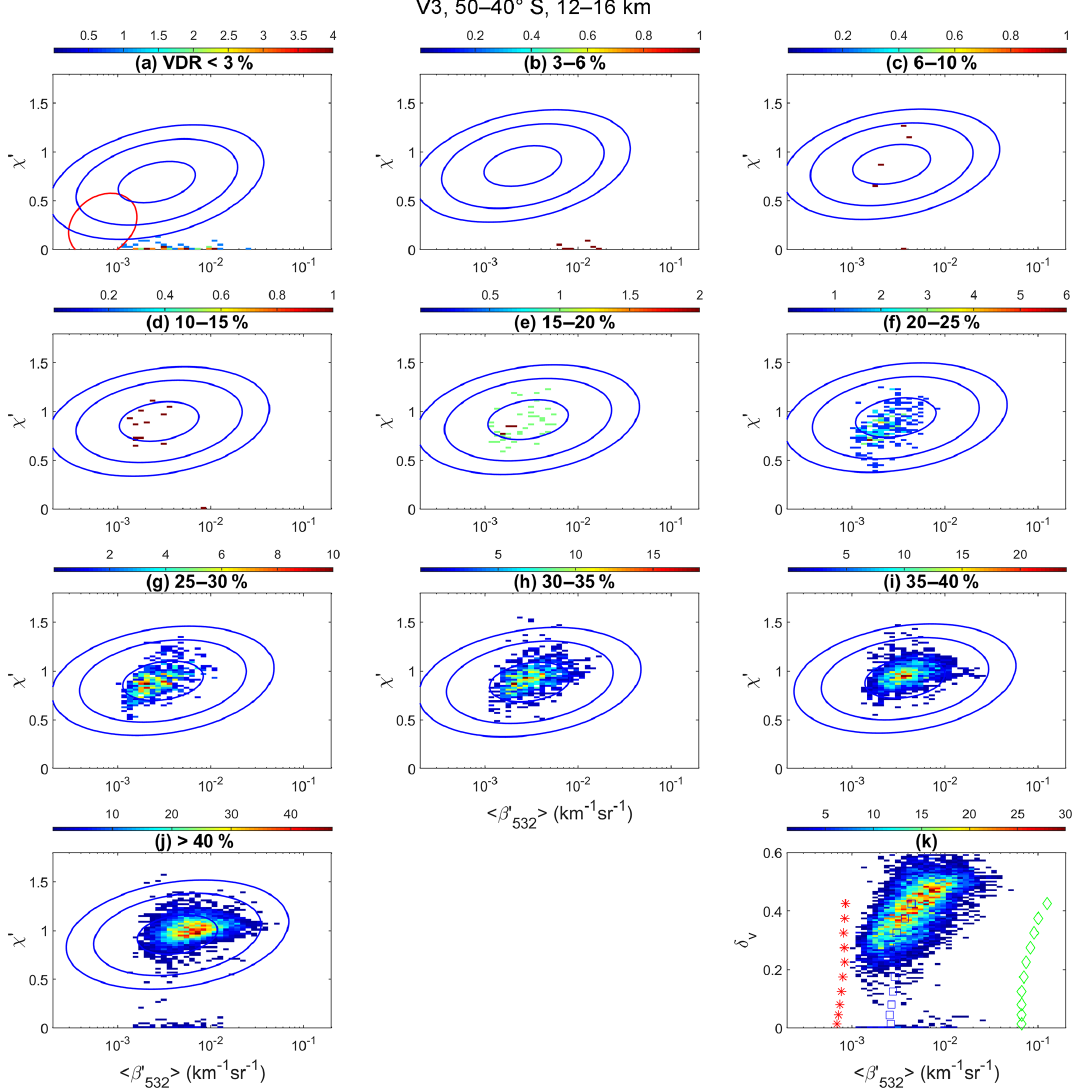
Figure 5. The same as in Fig. 4 but for V3 data acquired during 2008 only and used in the V3 PDF construction and the V3 PDFs